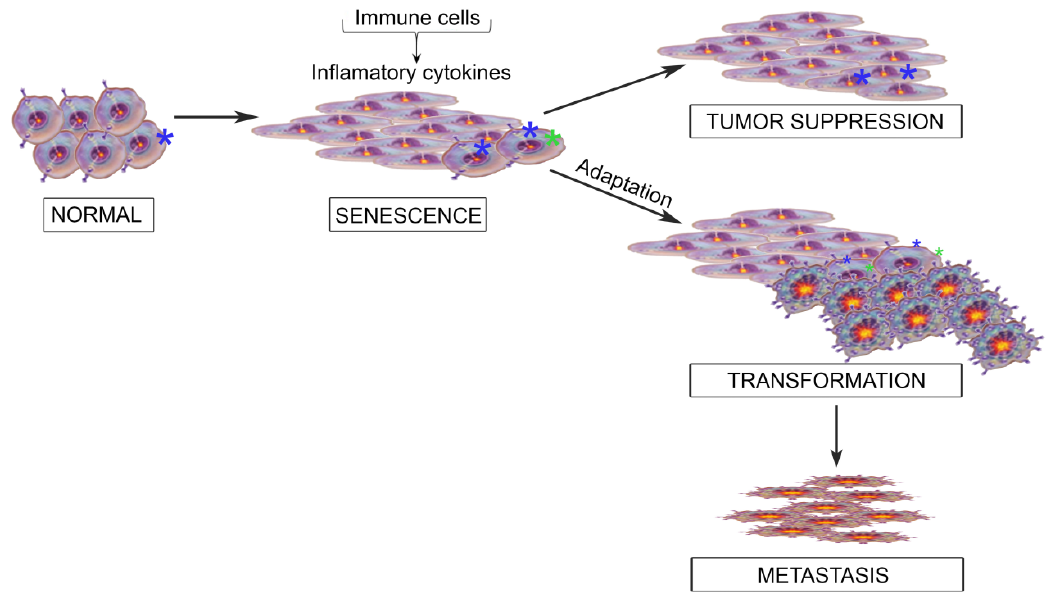
Figure 1. Modeling the role of inflammatory cytokines in cellular